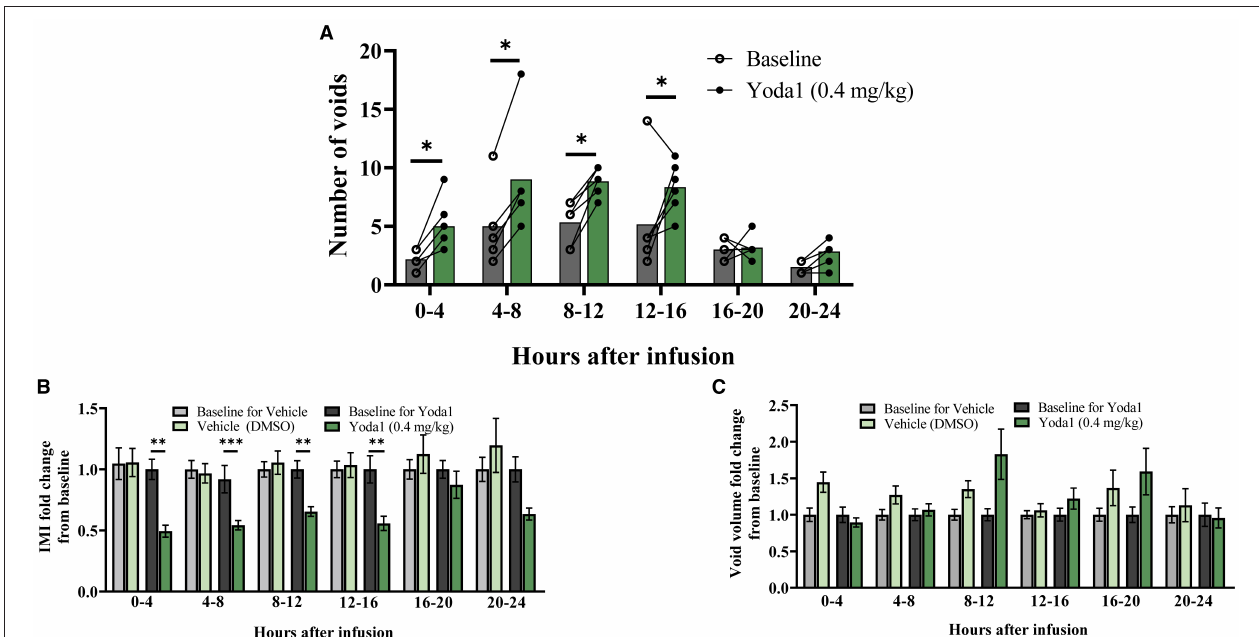
FIGURE 1 | Intravesical infusion of Yoda1 alters voiding function. The voiding function of conscious, freely moving, rats was studied for 24h post saline infusion (baseline) and compared to voiding function following Yoda1 (0.4 mg/kg) or vehicle (5% DMSO in saline) infusion. (A) In naïve (no CYP) female rats ( n = 6), activation of PIEZO1 with the agonist Yoda1 significantly increases number of voids at every timepoint studied until 16h after infusion ( P ≤ 0.05). (B) This increase in number of voids is matched by a significant decrease in the IMI at the same timepoints ( P ≤ 0.01, 0–4, 8–12, and 12–16h, and P ≤ 0.001 4–8h post infusion) compared to vehicle infusion ( n = 7). (C) These changes in voiding frequency after Yoda1 infusion do not result in any changes in void mass at any timepoint studied compared to vehicle infusion. Values are means ± SEM. Statistical analyses were performed using mixed model repeated measures ANOVA on square root (A) or natural log (B,C) transformed data. Fold-change transformation in (B,C) was done post-statistical analysis. * P ≤ 0.05; ** P ≤ 0.01; *** P ≤